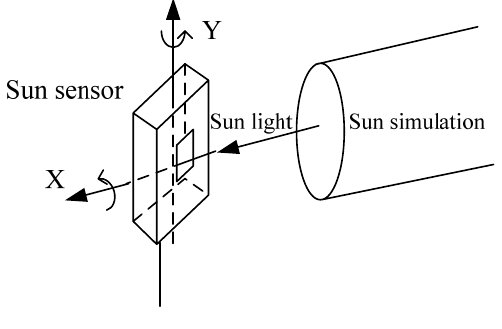
Figure 9. The diagram of an APS sun